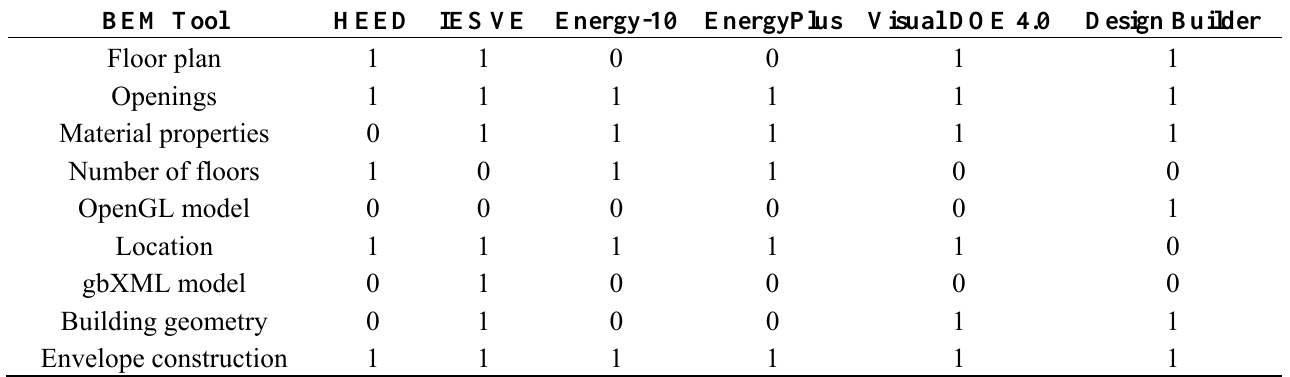
Table A3. Initial evaluation: available inputs criterion calculations for BEM tools (Part